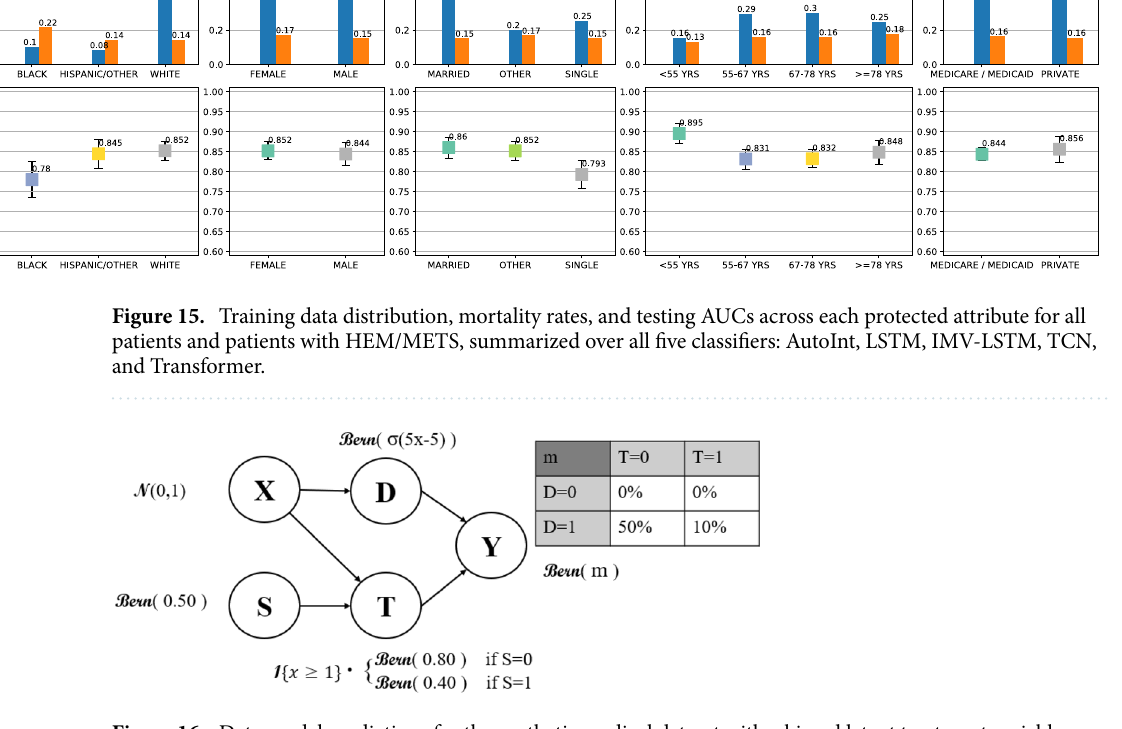
Figure 16. Data model predictions for the synthetic medical dataset with a biased latent treatment